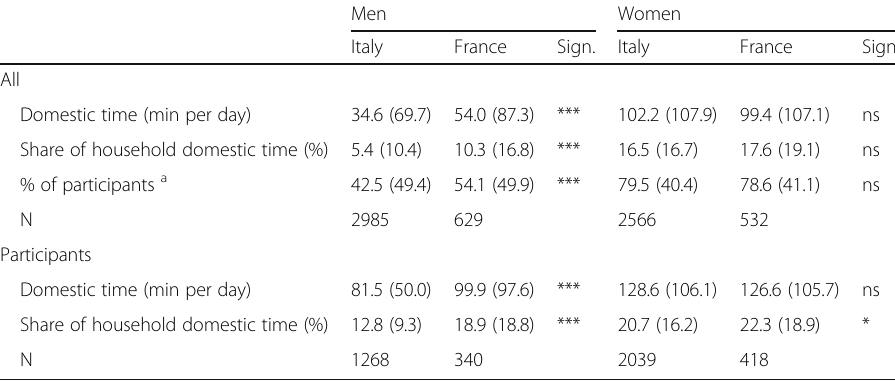
Table 2 Domestic participation of young adults living at parental home in France and Italy by gender Men Women Italy France Sign. Italy France